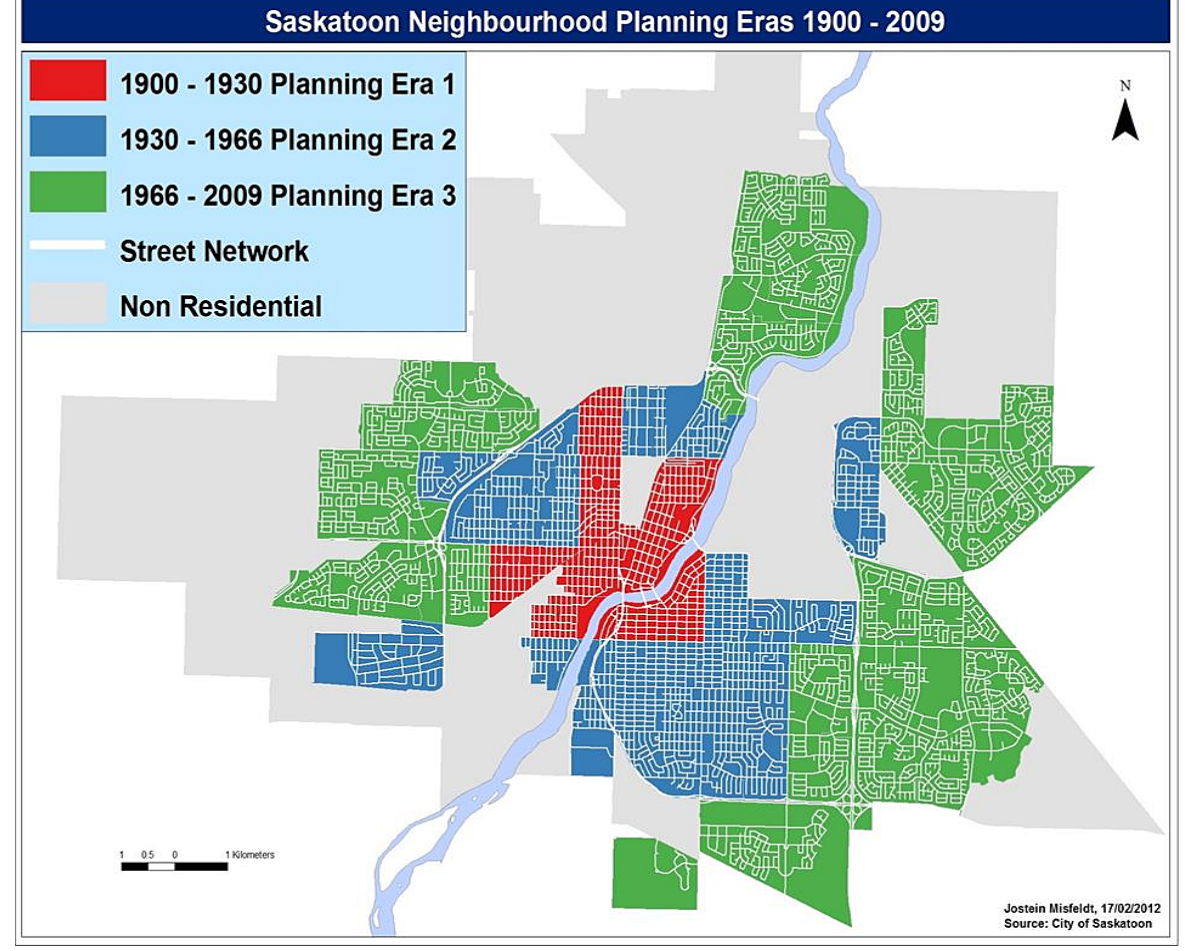
Figure 1. Urban design of Saskatoon depicting the three types of neighbourhoods (grid; fractured grid;